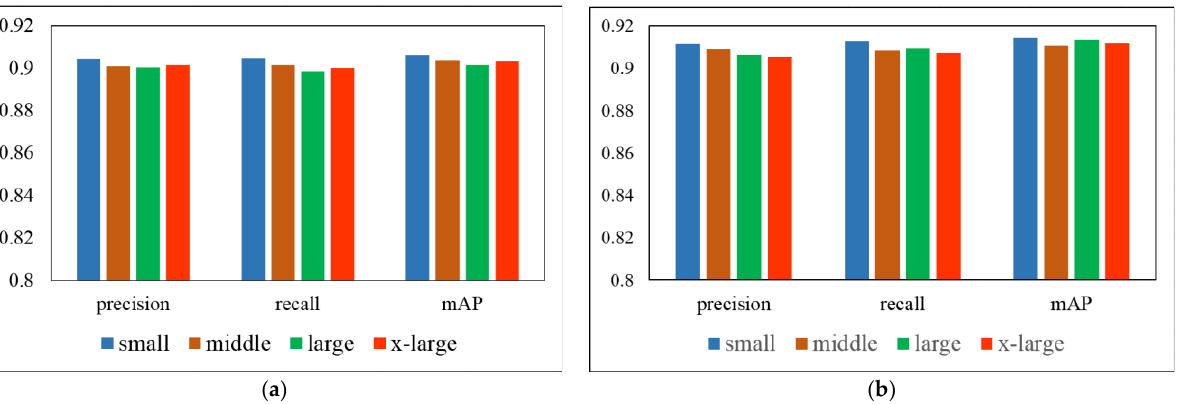
Figure 15. Comparison of detection accuracy based on networks with different depths and widths. ( a ) YOLOv5 series; ( b ) proposed methods.